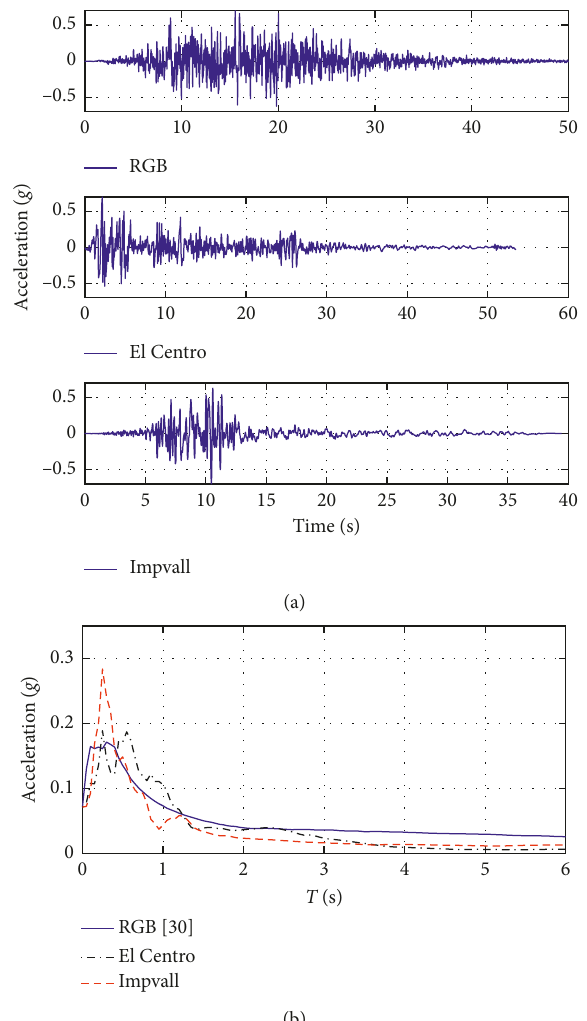
Figure 10: (a) Time history of seismic acceleration. (b) Response spectrum of seismic